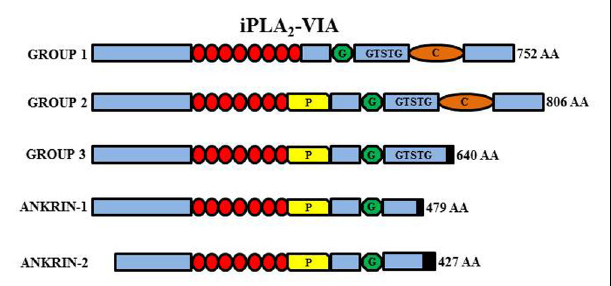
FIGURE 5 | Schematic representation of the different iPLA2-VIA isoforms. GroupVI-1 is characterized by the presence of eight ankyrin repeats (red circles), a glycine-rich, nucleotide-binding motif (G), a consensus lipase motif (GXSXG), and a calmodulin binding motif (C). Group VI-2 has the insertion of a proline-rich motif (P) in place of the eighth ankyrin repeat. GroupVI-3 has a truncated COOH-terminus but conserve the lipase motif while the ankyrin-1 and -2 lack the active site and are